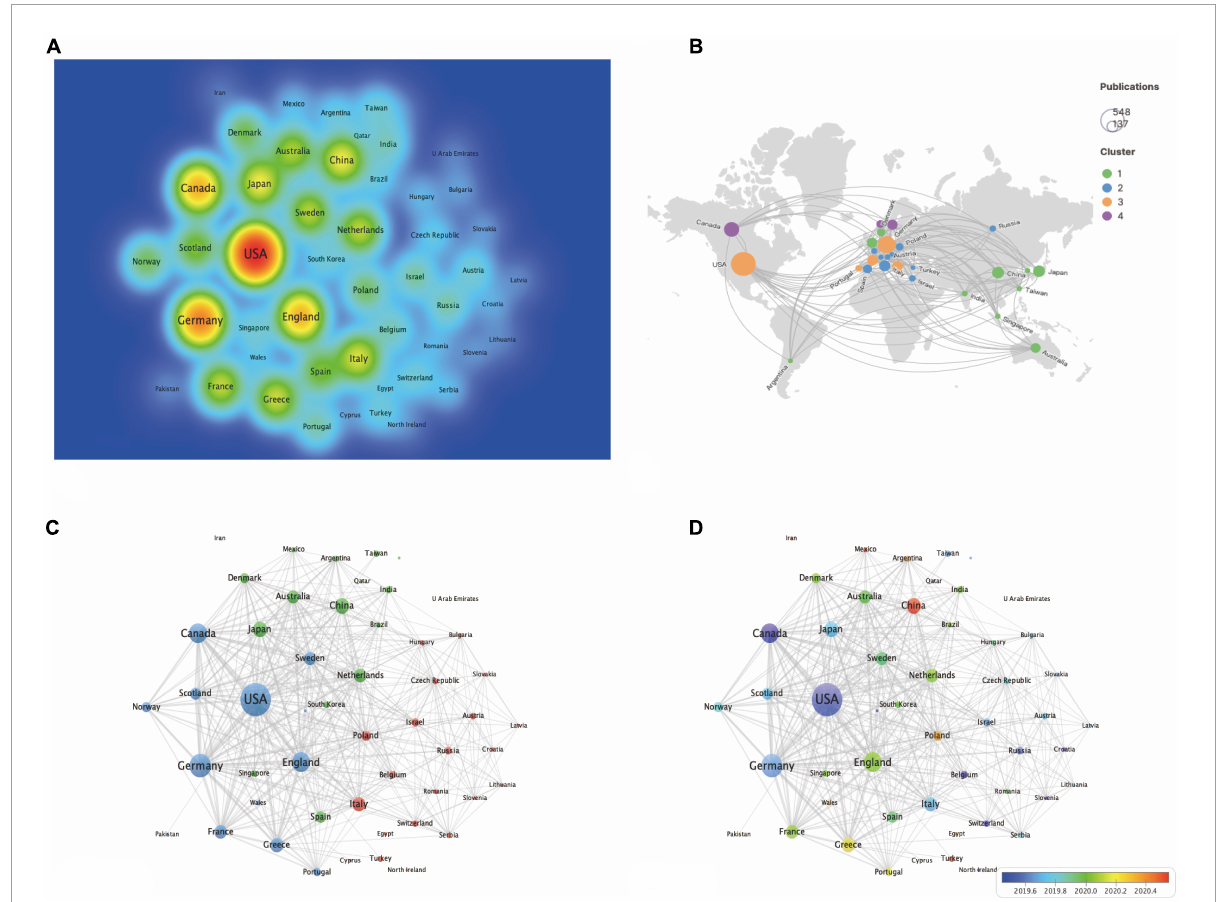
FIGURE2 The analysis of country/region. (A) The destiny of all contributing countries. (B) The cluster of all contributing countries by Scimago. (C) The occurrence of all contributing countries. (D) The time overlay of all contributing countries.